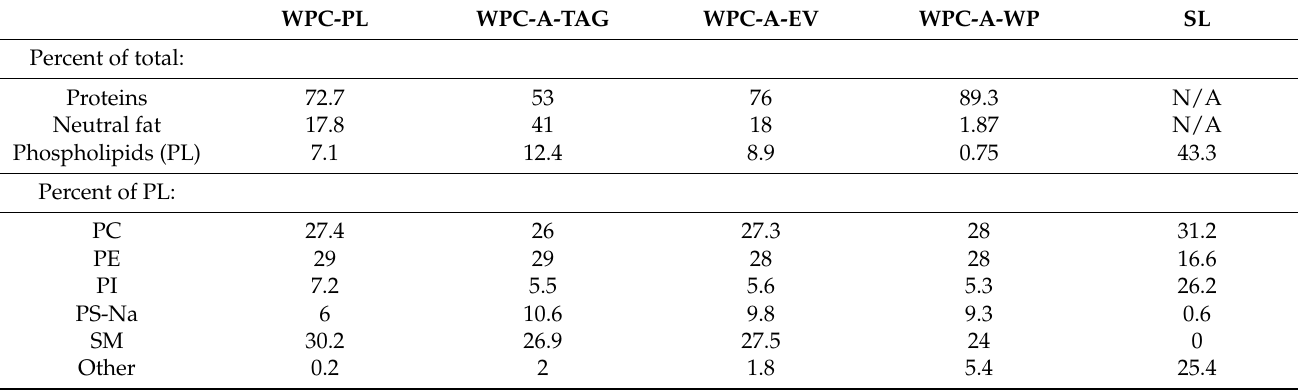
Table 1. Emulsifier composition of protein, neutral fat, and phospholipids. WPC-PL